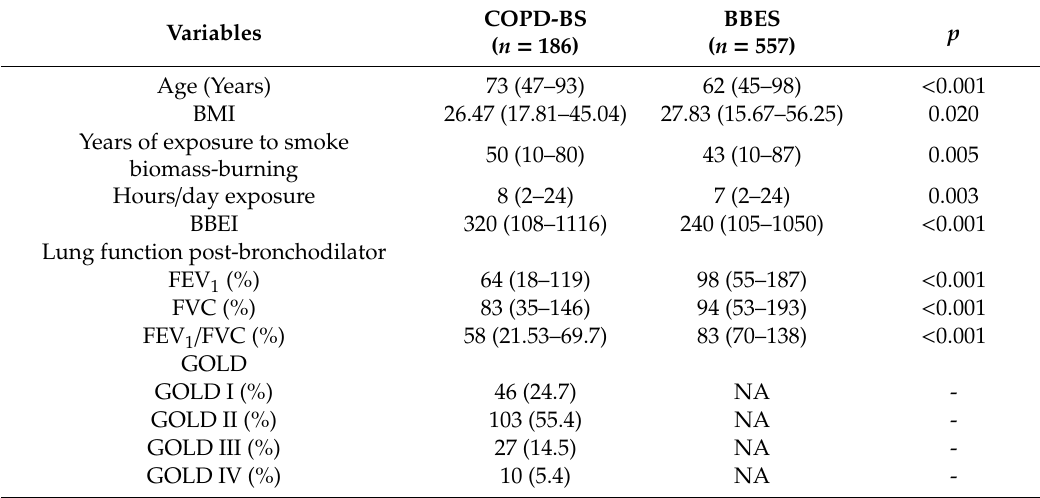
Demographic, clinical, exposure and lung function of participants exposed to biomass-burning